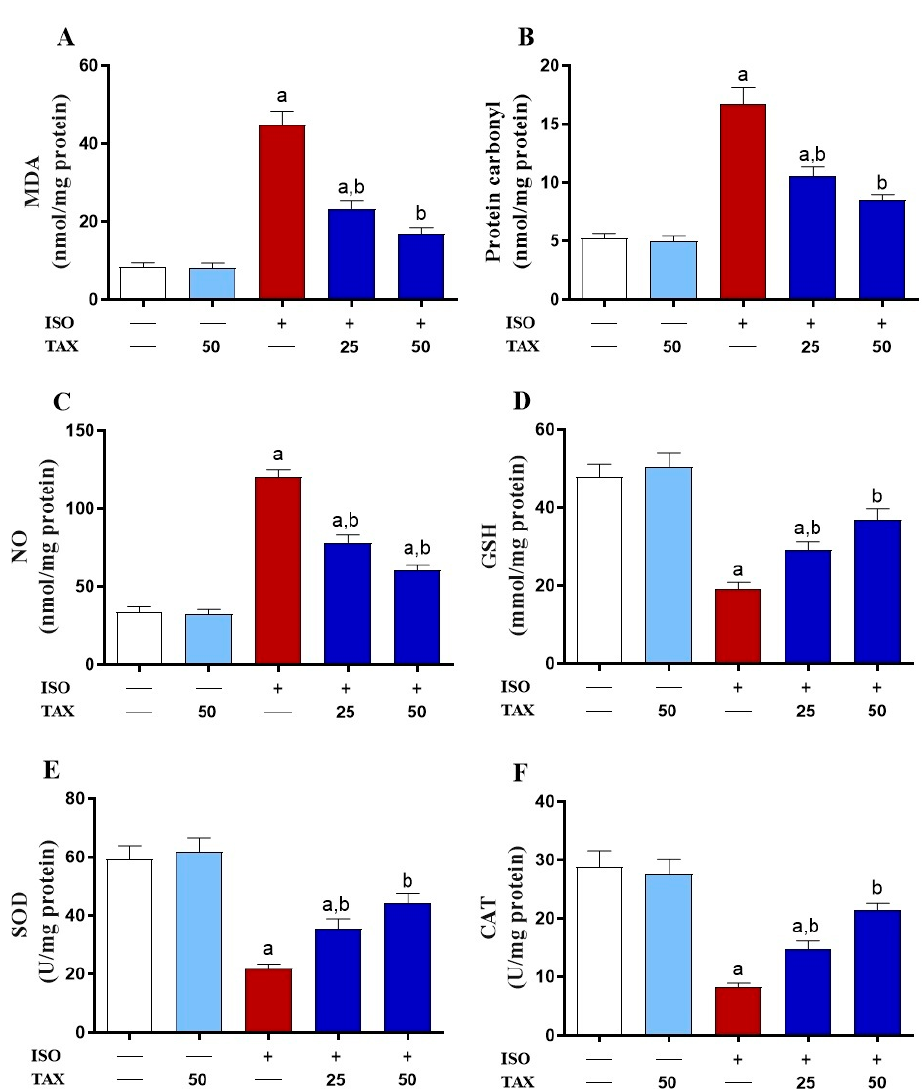
Figure 4. TAX attenuates the ISO-induced myocardial oxidative stress. Pre-treatment with TAX reduced cardiac levels of ( A ) MDA, ( B ) protein carbonyl, ( C ) NO, and elevated ( D ) GSH level, and activities of ( E ) SOD and ( F ) CAT in ISO-injected mice. Data are expressed as mean ± SEM, ( n = 6). Here, a indicates significant ( p < 0.05) vs. control, while b indicates significant ( p < 0.05) vs. ISO.